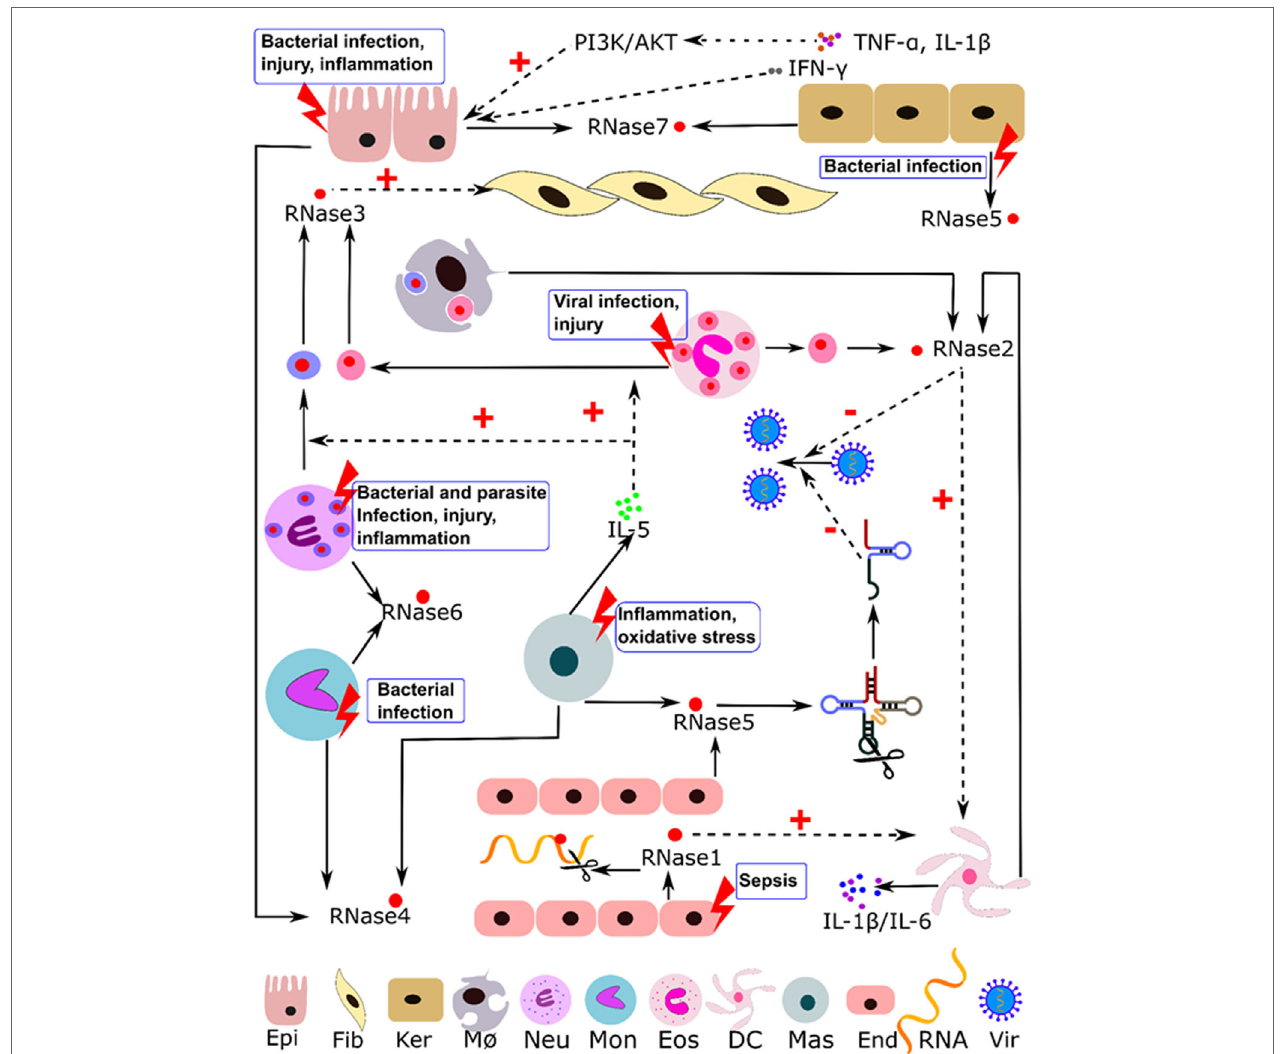
FiGURe 1 | Illustration of the immuno-modulatory properties reported for human RNaseA family members. Induction stimuli, expression cell type, and regulation pathways are indicated. Abbreviations: Epi, epithelial; Fib, fibroblast; Ker, keratinocytes; MØ, macrophages; Neu, neutrophils; Mon, monocytes; Eos, eosinophils; DC, dendritic cells; Mas, mast cells; End, endothelial cells; Vir, virus; dotted line indicates regulation paths and solid line indicates expression and secretion